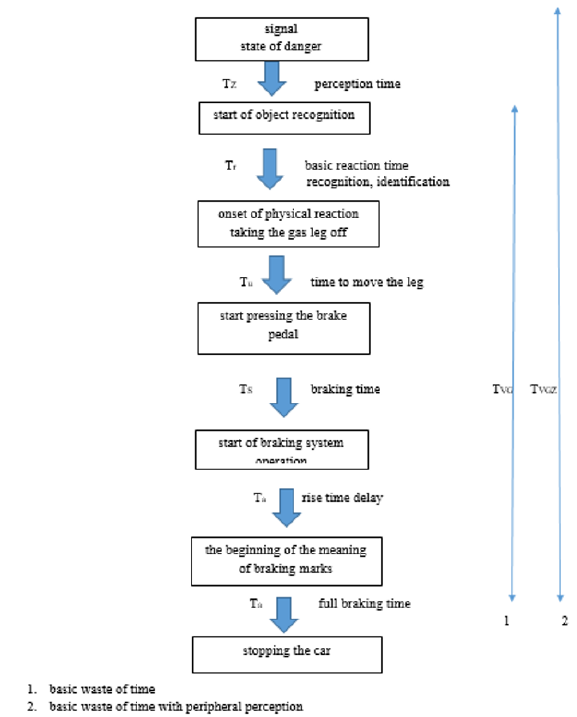
Figure 1: Diagram of the driver’s reaction to the braking manoeuvre of the vehicle [12]. Table 2: Possible time values resulting from statistical analysis [12].